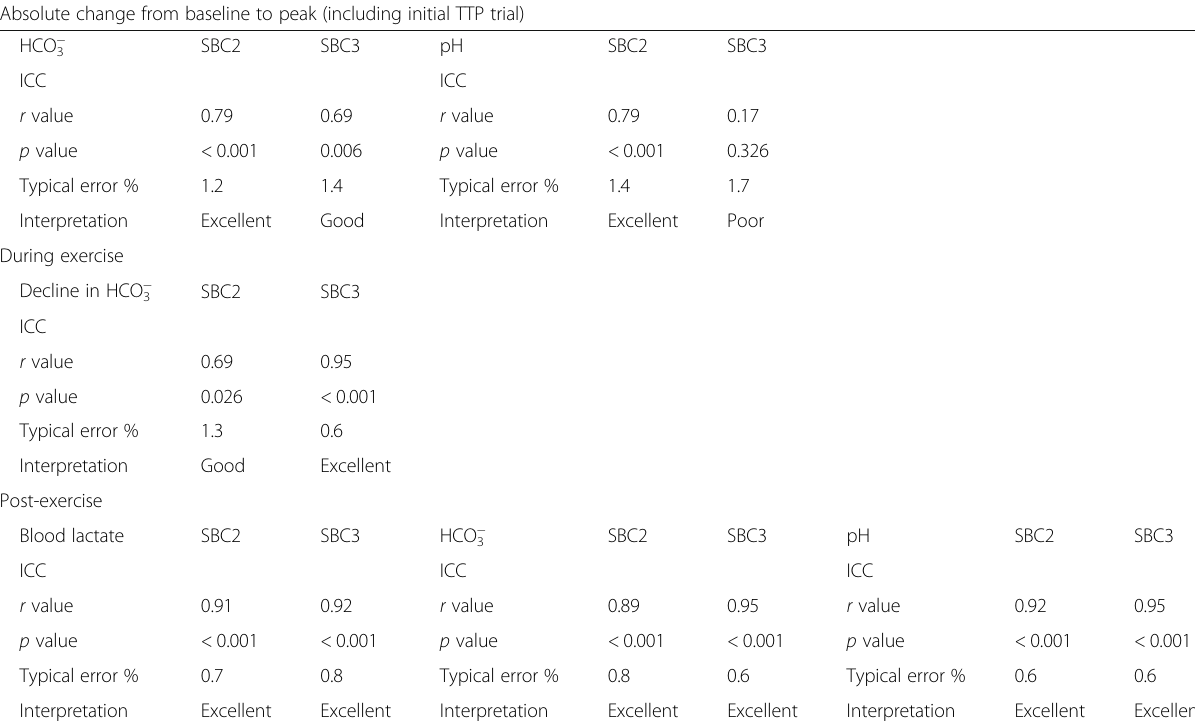
Table 1 Overview of intraclass correlation coefficients (ICC) and typical error (TE) statistical analysis following sodium bicarbonate (NaHCO 3 ) treatments (SBC2 and SBC3) on pre-, during and post-exercise blood pH, bicarbonate (HCO 3 − ) and lactate Absolute change from baseline to peak (including initial TTP trial)